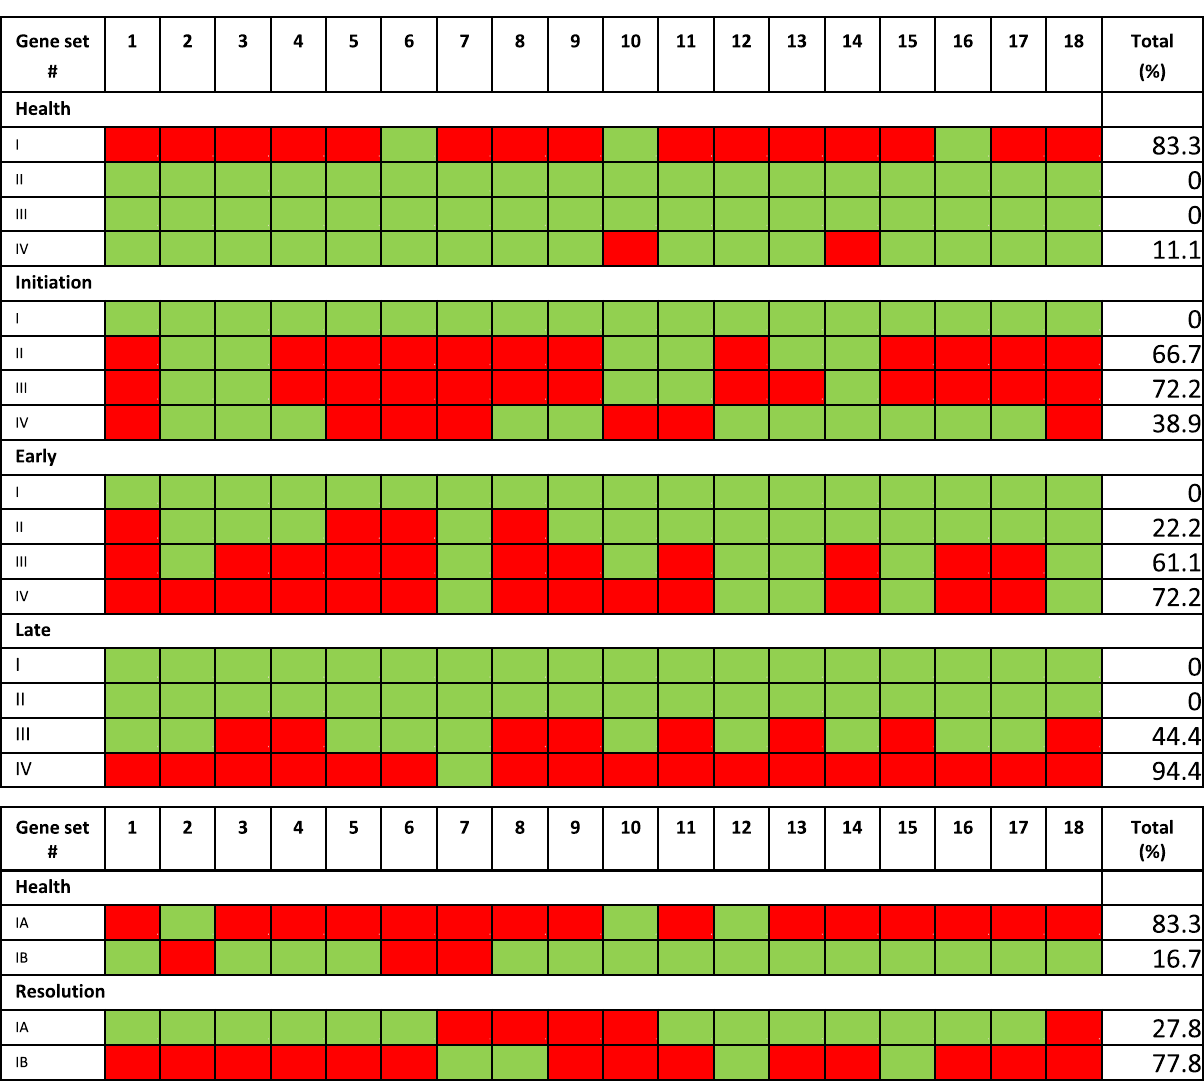
Figure 6. Map of response profiles for gene clusters for the 18 samples obtained at each of the timepoints. Red denotes sample demonstrated: Cluster I—> 13 genes; Cluster II—> 9 genes; Cluster III—> 7 genes; Cluster IV—> 7 genes with signal greater or less than the threshold cutoff normalized signal (T c , Table 3). Green denotes sample exhibited fewer genes above or below the T c . Similar depiction of the distribution of responses to Cluster I genes subgrouped into IA and IB. Red denotes IA—> 2 genes and IB—> 3 genes above/below the T c (see Table 3). Total % denotes proportion of the samples that were positive in the gene expression